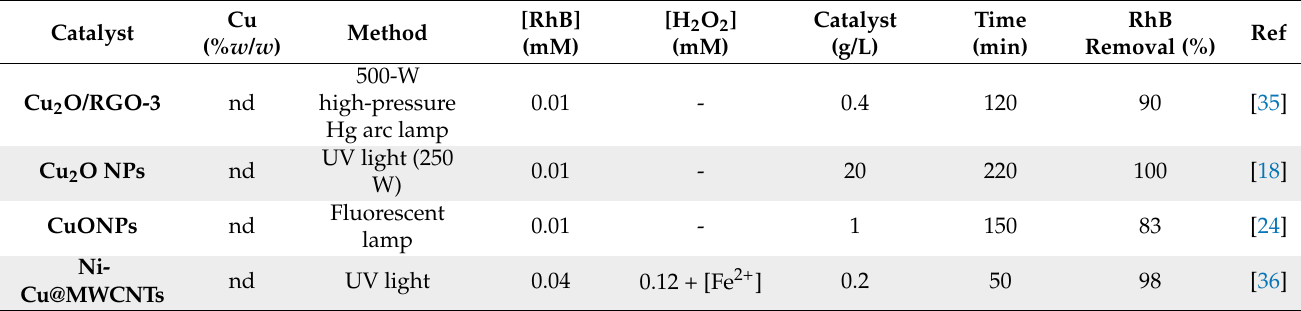
Figure S4: analysis of stability of G@TLL-Cu2O hybrid. Figure S5: Study of adsorption of TCE to G@TLL. Figure S6: Characterization of TLL-Cu2O hybrid Figures S7–S10: Additional experiments